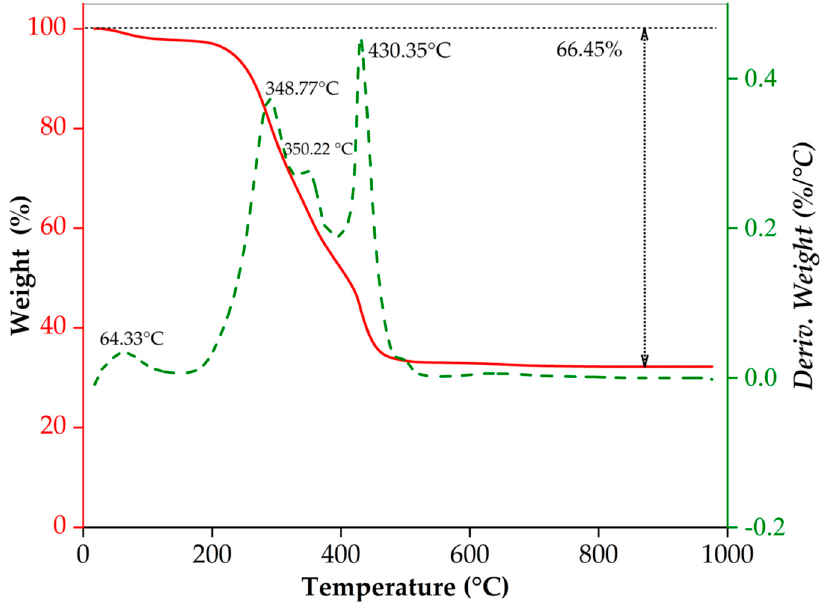
Figure 1. TGA of the fresh prepared samples by modified Pechini method.